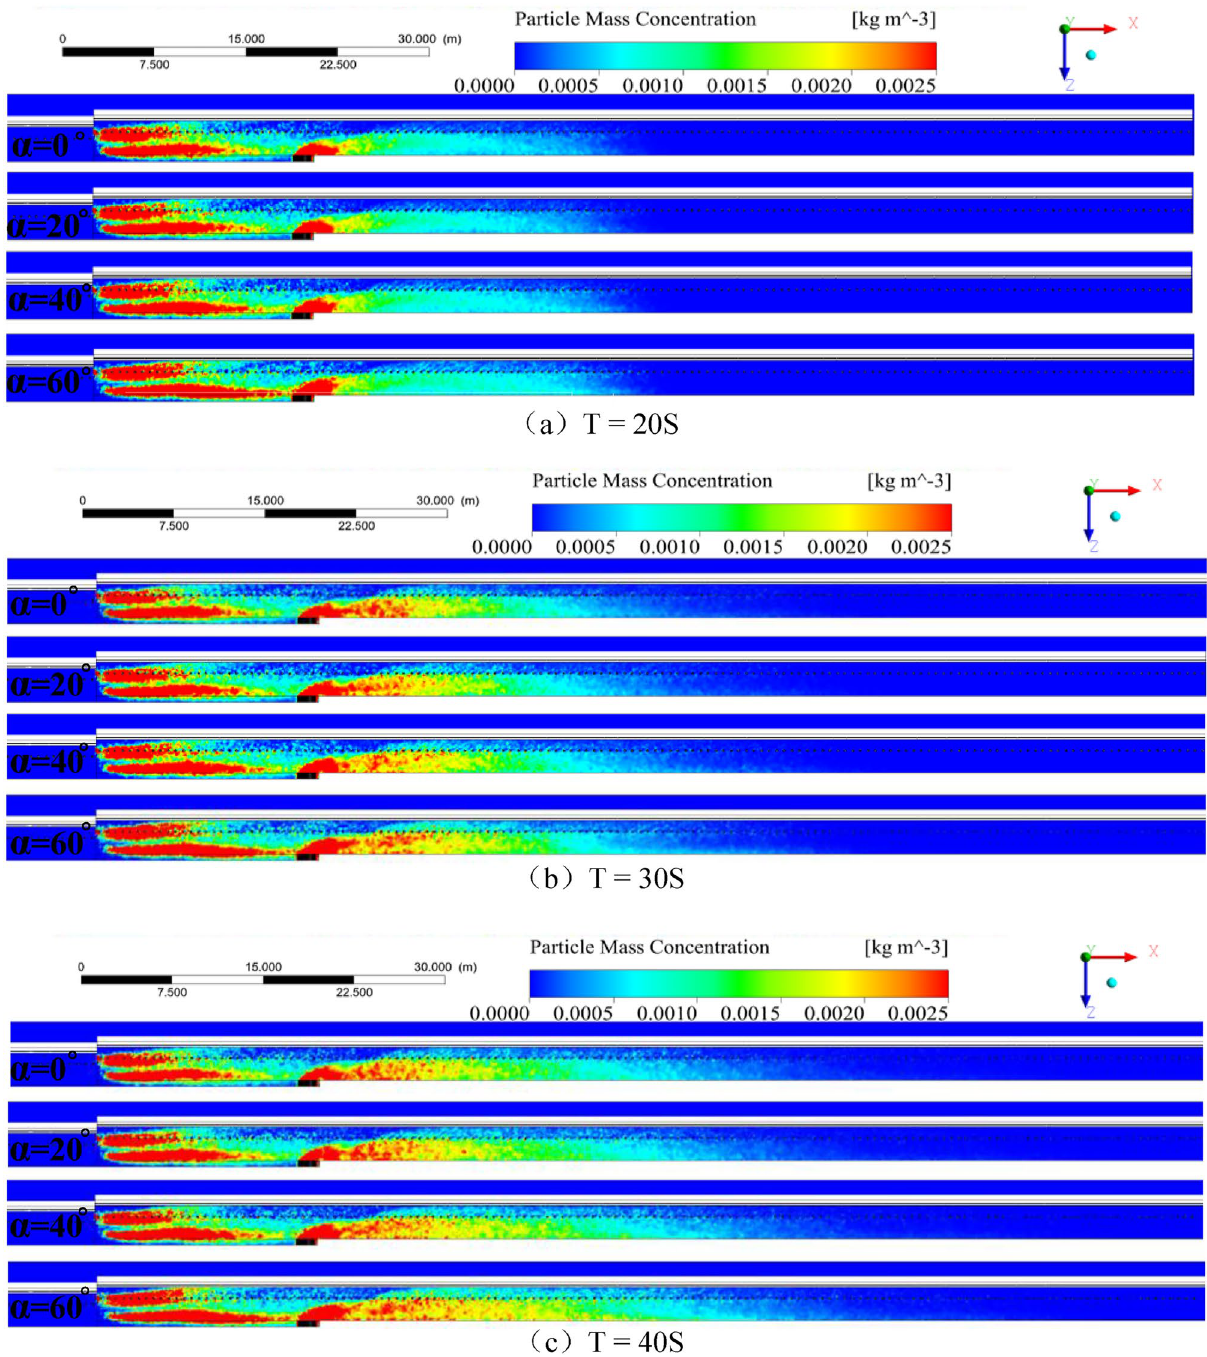
Figure 5. Time chart of dust dispersion distribution at working face Y = 2.8 m (T = 20, 30, 40, 60,